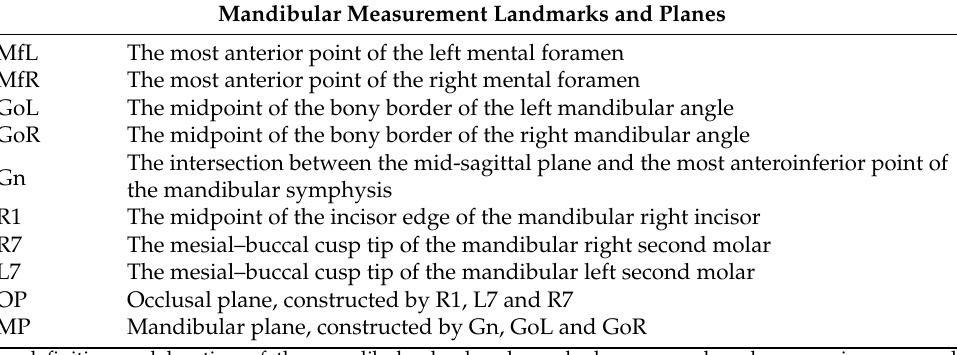
Table 2. Mandibular measurement landmarks and planes.